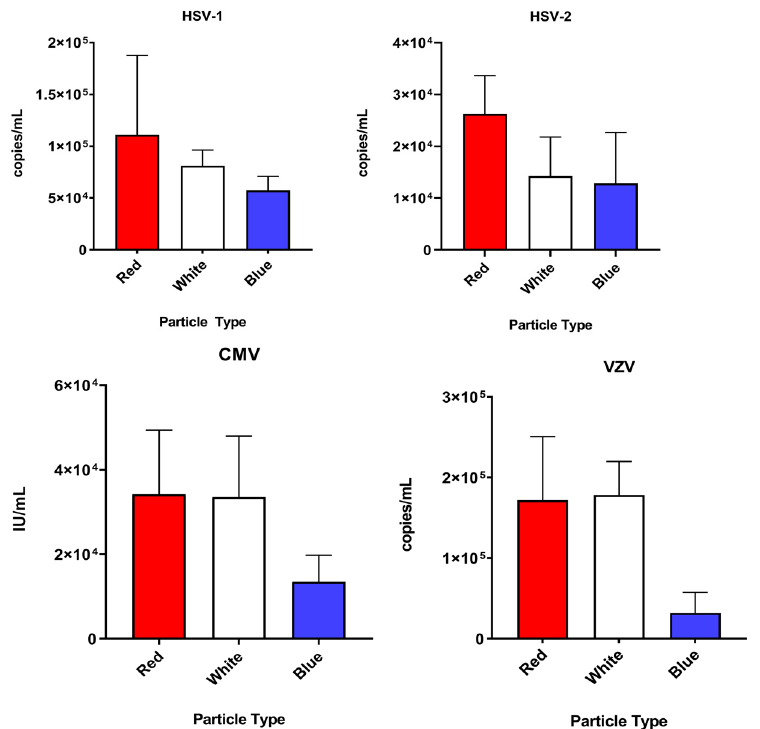
Figure 4. A comparison of the three particle types tested (Nanotrap Red, Nanotrap White, and Nanotrap Blue) against the four herpesviruses tested in this study. Table 1. Mean and standard deviation values (in cp/mL) for each of the custom Nanotrap particle types tested: Nanotrap Red, Nanotrap White, and Nanotrap Blue.